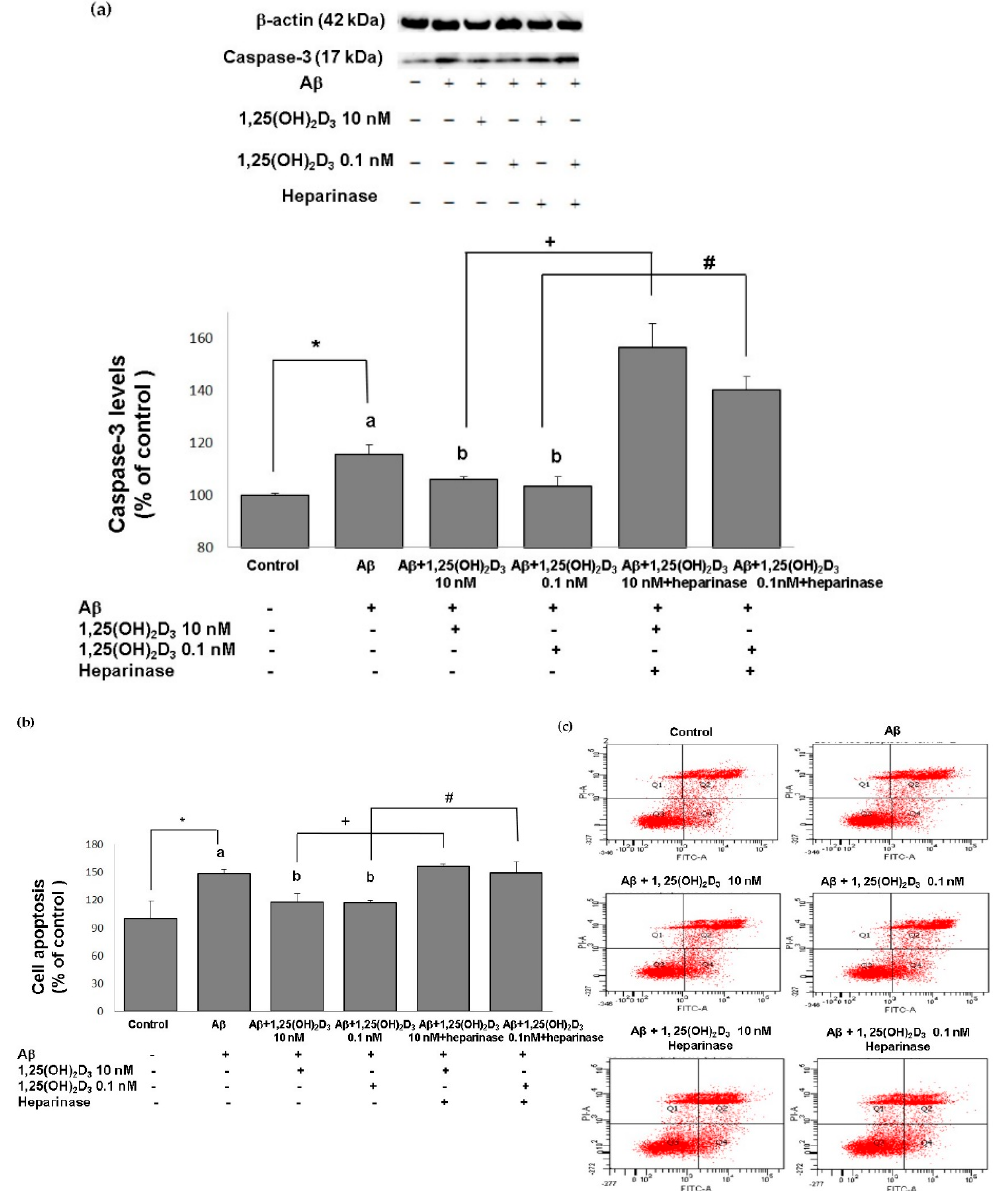
Figure 3. Effects of 1,25(OH) 2 D 3 on A β -induced changes in cell apoptosis. ( a ) Western blot analysis